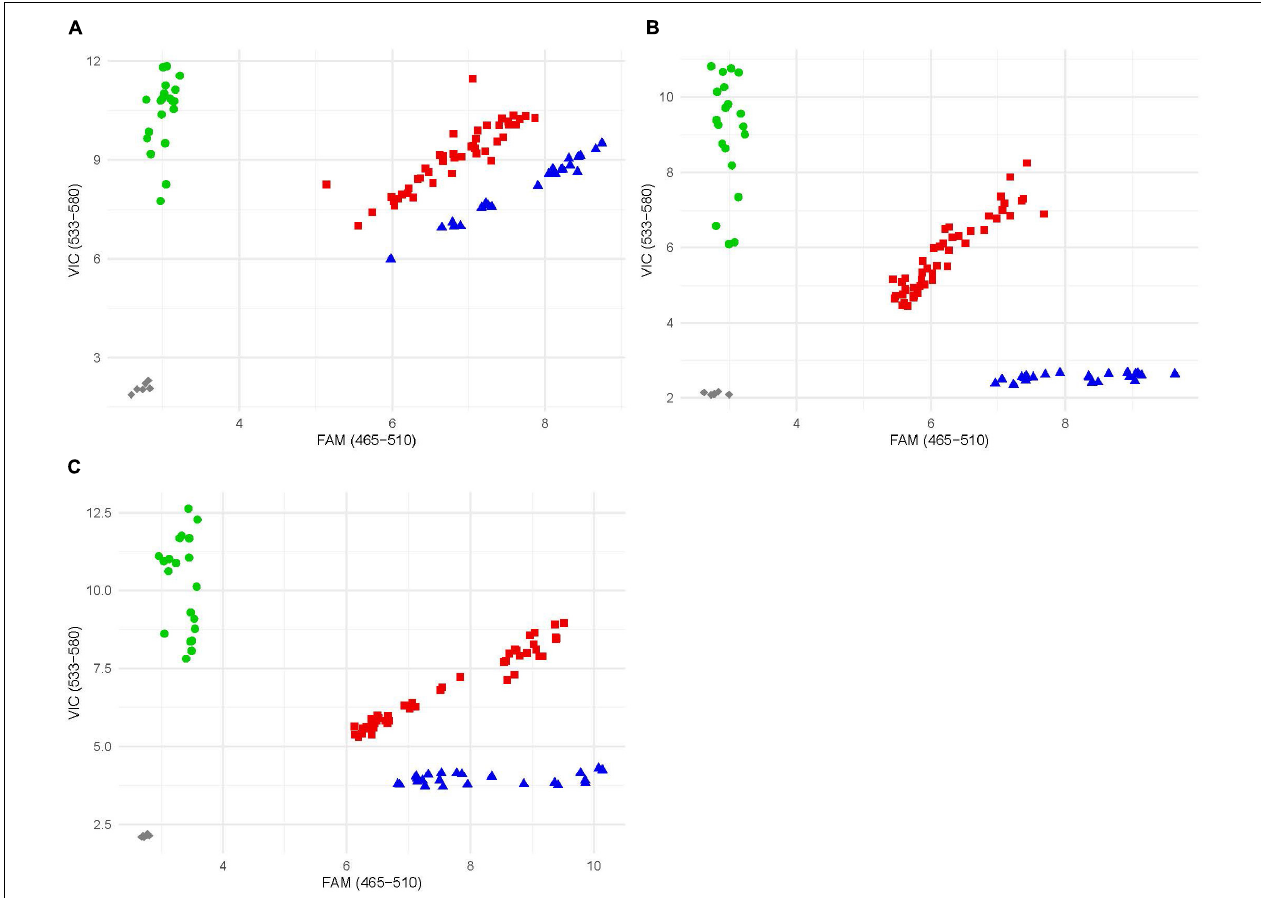
FIGURE 3 | Example endpoint fluorescence scatter plot of KASP markers; x -axis is FAM fluorescence; y -axis is VIC fluorescence. Blue triangles represent individuals homozygous for the resistant allele, green circles represent individuals homozygous for the susceptible allele, and red squares represent individuals that possess both alleles. Gray diamond are no template controls. (A) Plot of marker kelse6BS_167037. (B) Plot of marker kelse6BS_4554201. (C) Plot of marker